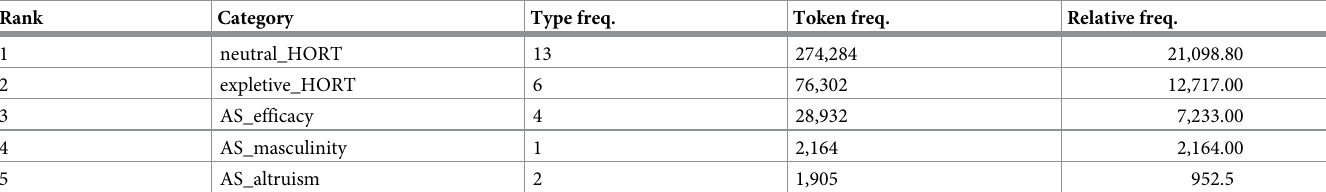
Table 3. Functional subcategories of pro-mask hashtags ranked by relative frequency. Rank Category Type freq. Token freq.